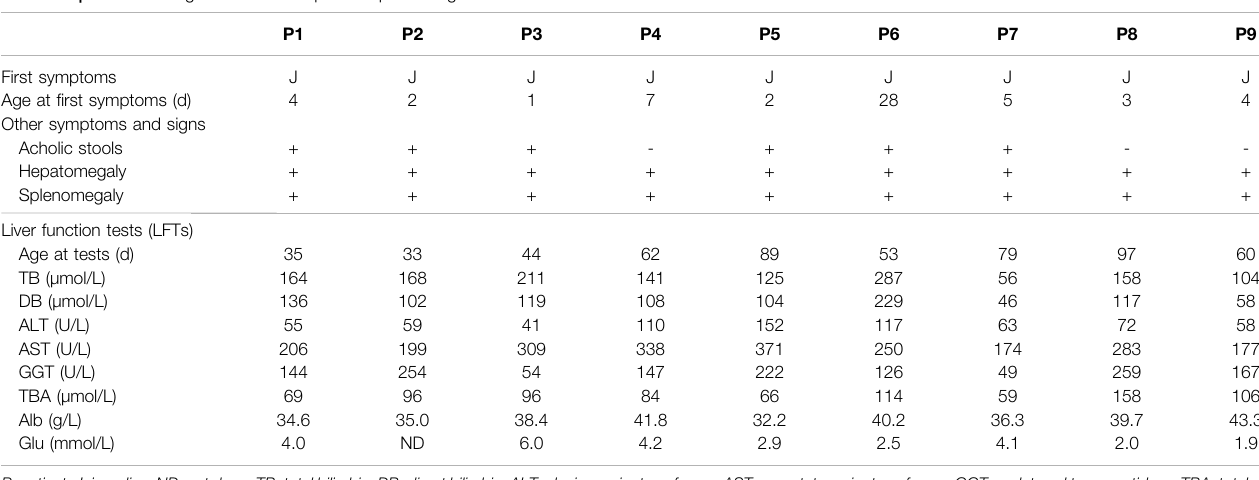
TABLE 2 | Clinical fi ndings of the 9 NPC patients presenting as neonatal cholestasis.